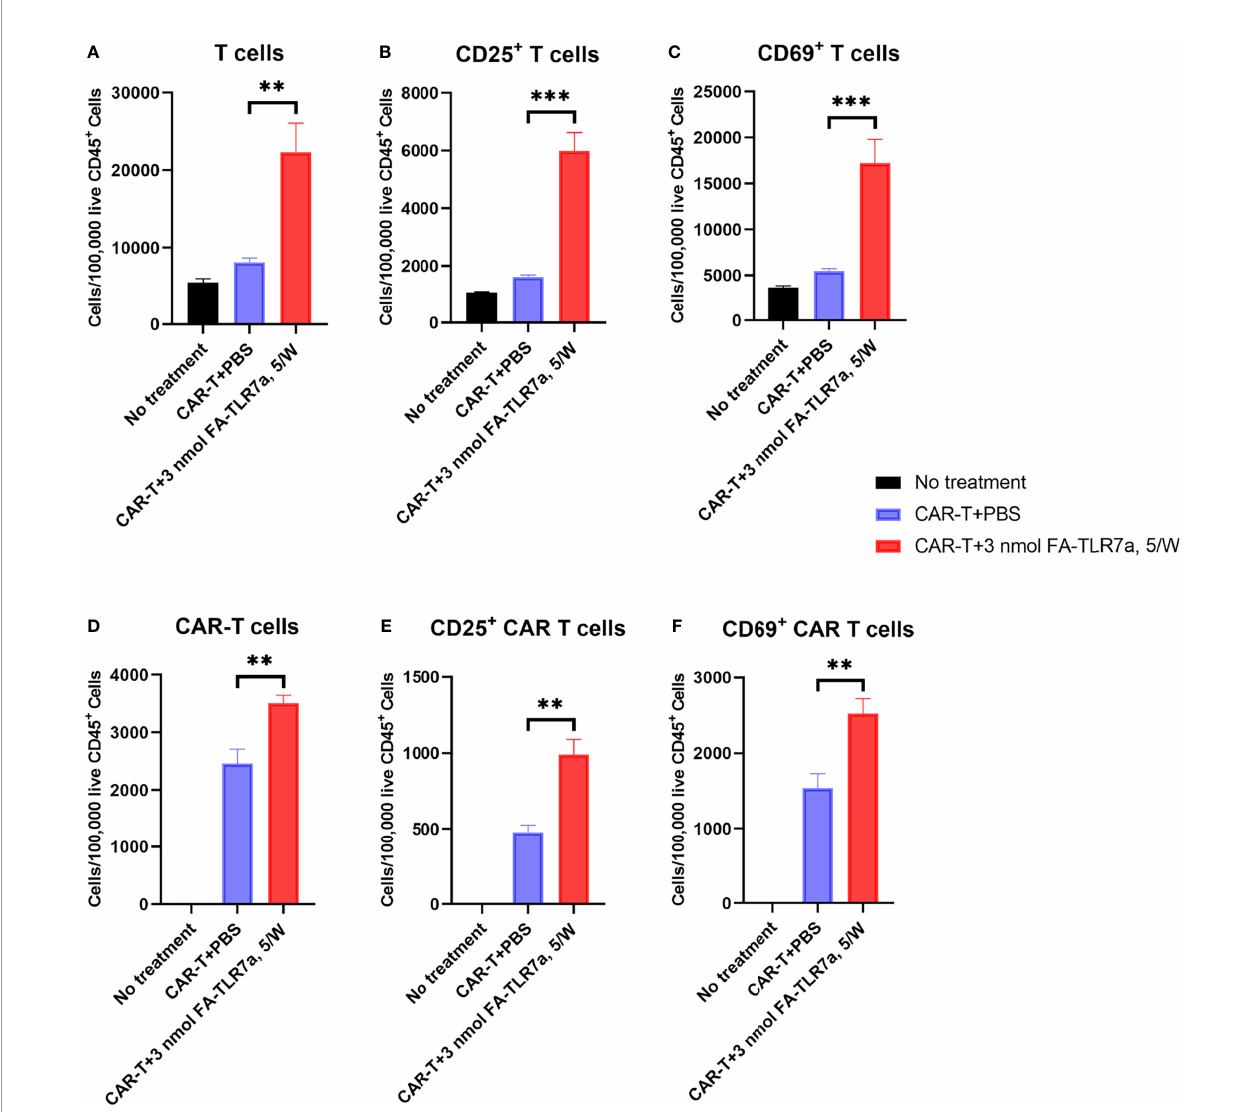
FIGURE 6 | Impact of CAR T cell therapy in the presence and absence of FA-TLR7-1A on the number and activation states of tumor-in fi ltrating T cells and CAR T cells. (A – C) The number of total T cells, CD25 + T cells, and CD69 + T cells per 100,000 live CD45 + cells in the tumors following the indicated treatments. (D – F) The number of total anti-CD19 CAR T cells, CD25 + anti-CD19 CAR T cells, and CD69 + anti-CD19 CAR T cells per 100,000 live CD45 + cells in the tumors following the indicated treatments. This study was performed three times with similar results each time. The number of mice/group is the same as reported in the legend to Figure 3 , except in the CAR-T + 3 nmol FA-TLR7-1A, 5/W group only 5 of 9 tumors could be analyzed because 4 of 9 mice experienced complete cures. Mean ± SEM. Statistical signi fi cance was determined using an unpaired two ‐ tailed t ‐ test (**P < 0.01, ***P <